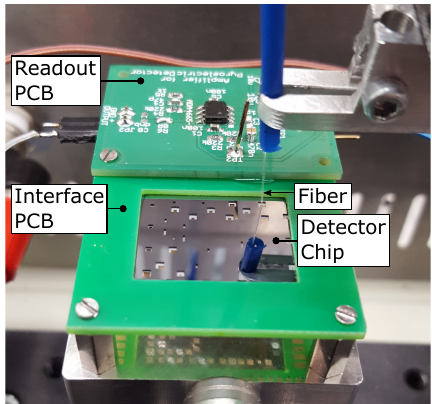
Figure 2. A section of the measurement configuration, depicting the backside of a detector chip which is mounted in the interface PCB, together with the attached readout PCB and the optical fiber. The optical fiber is approached to the backside of a